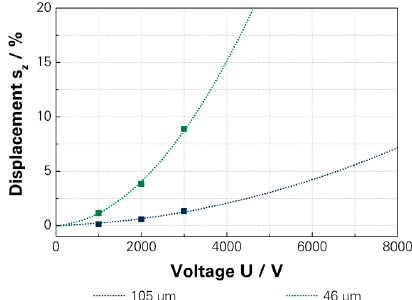
Figure 9. Measured actuation displacements and characteristic curves of full polymer DEA with different thick dielectric layers [15]—Table S1: actuators 2 and 7.